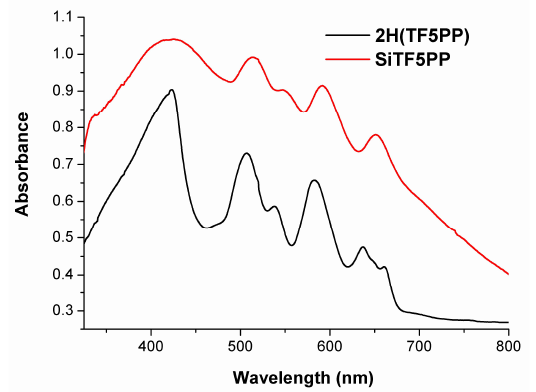
Figure 4. Solid-state UV-Vis spectra of H 2 TF 5 PP and of the hybrid SiTF 5 PP .